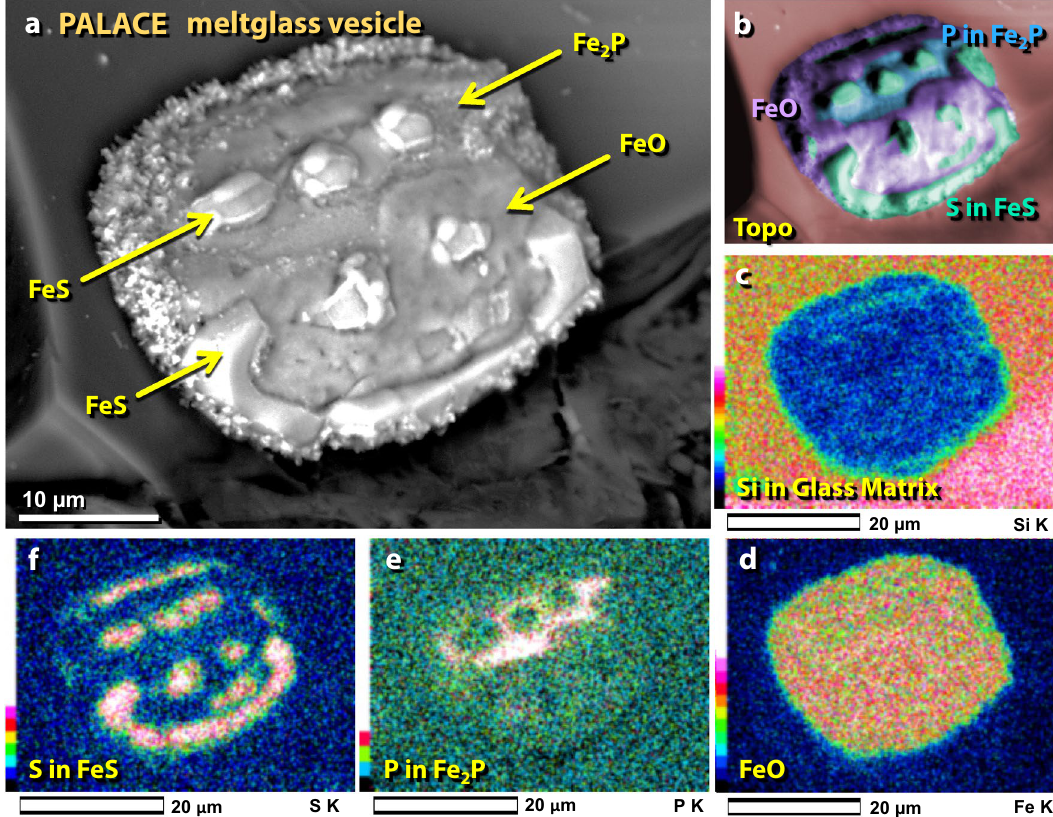
Figure 40. SEM images of Fe-S-P-enriched nugget in vesicle of mudbrick meltglass from the palace. ( a ) Chemically complex nugget inside a vesicle; contains Fe, S, and P. ( b ) Manually constructed EDS-based phase map showing that nugget is dominantly composed of Fe oxides, S as FeS, and P as Fe 2 P. ( c )–( f ) SEM–EDS elemental maps showing the composition of nugget by regions.